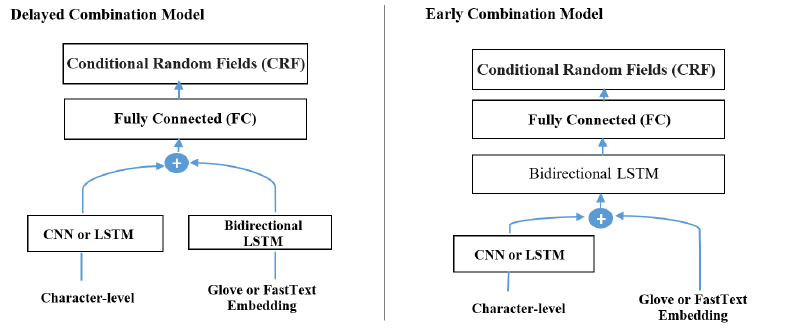
Figure 6. The comparison between delayed and early